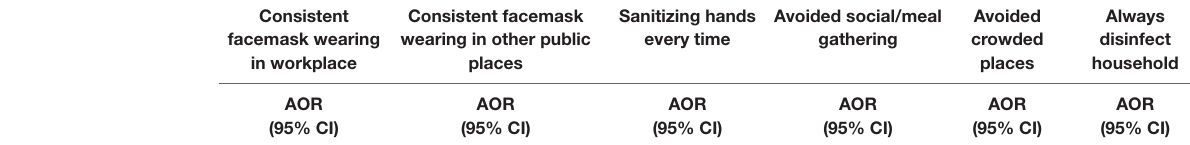
TABLE 3 | Baseline factors predicting personal preventive behaviors at Month 3 (results of multivariate multilevel logistic regression models; level 1: factories, level 2: individual